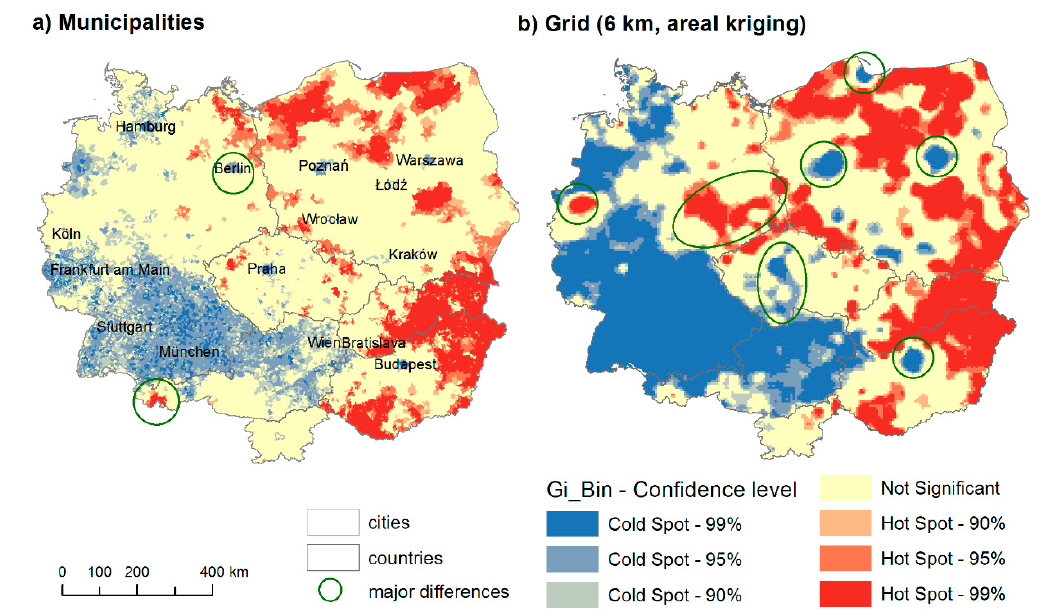
Figure 6. Comparison of hot spot analysis of unemployment in municipalities ( a ) and grid ( b – 6 km, areal kriging). Source: © EuroGeographics for the administrative boundaries, European Commission, Eurostat/GISCO